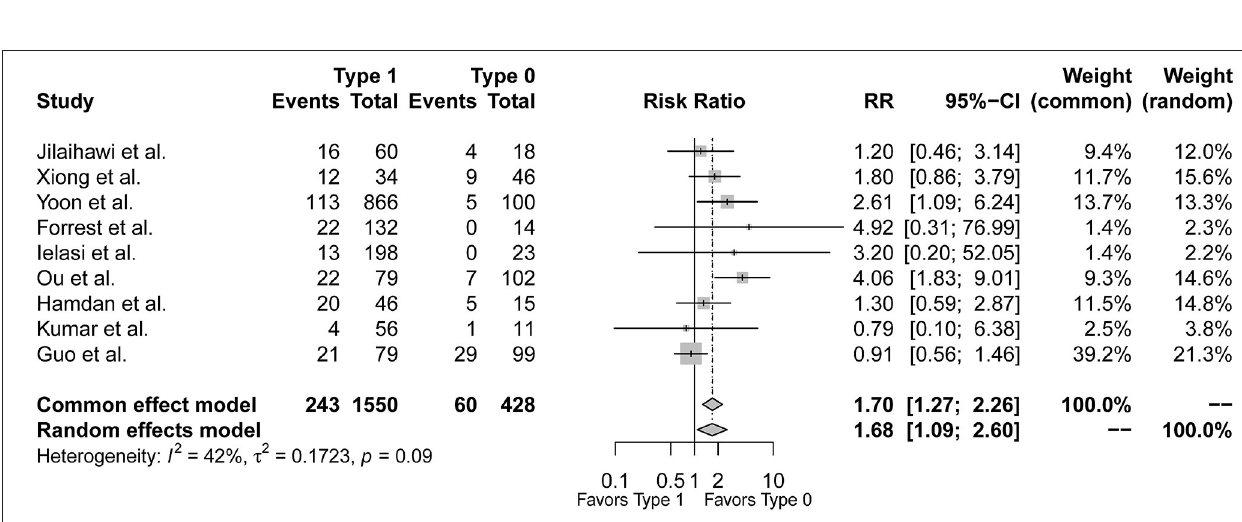
FIGURE 3 | The forest plot of the pooled-analysis comparing post-TAVR conduction abnormalities between Sievers type 1 and type 0 BAV morphology. RR, risk ratio; CI, confidence